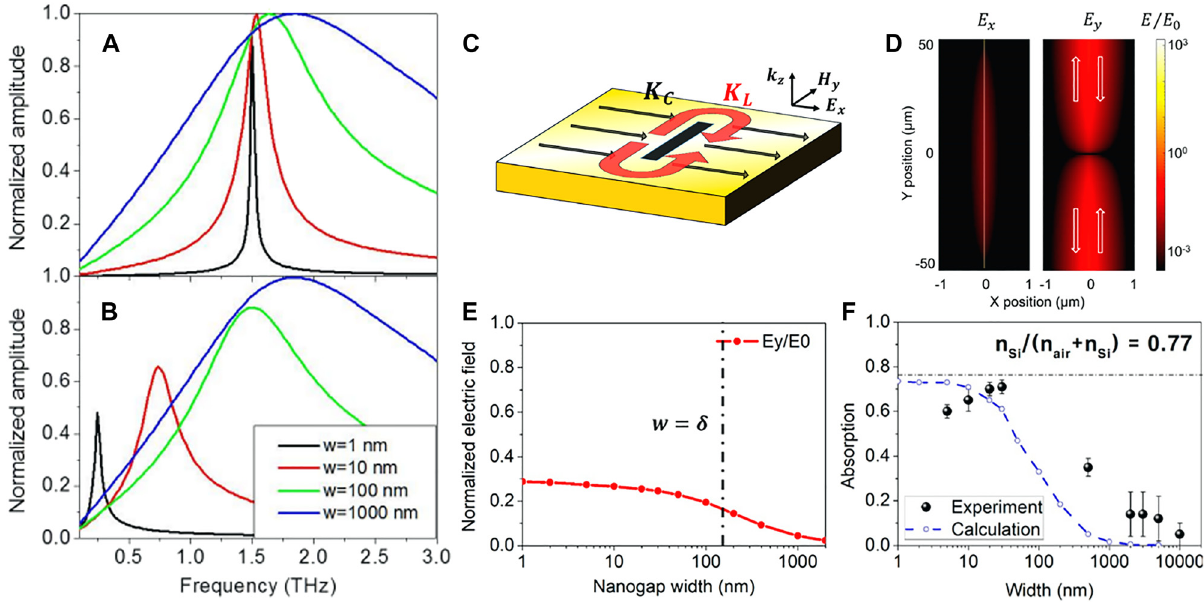
Figure 3: Gap plasmon effects in sub-skin-depth-wide metallic nanogaps. (A) and (B) Calculated transmission spectra of metallic nanogaps with different widths w , assuming A perfect conductor and B gold as the metal, respectively. (C) Two current components that contribute to electric fi eld enhancement in nanoslot antennas. Despite commonly accepted picture of capacitive fi eld enhancement at the gap, inductive current K L can be the dominant contribution over its capacitive counterpart K C . (D) Calculated electric fi eld in the vicinity of a 10 nm-wide metallic gap. (E) Maximum amplitude of the inductive fi eld E y as a function of gap width. Dashed line denotes skin depth δ at 1 THz. F Measured and calculated peak absorption of terahertz radiation in nanoslots with different widths. Reproduced with permission from [42] (A) and (B) and [43] (C) –